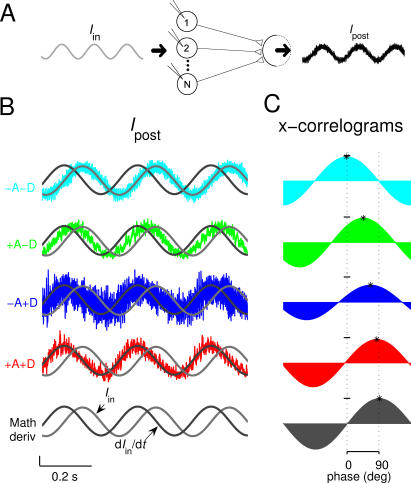
Phase Advances Induced by SFA and STD in the Network Model(A) Scheme of the spiking neuron network employed (N = 300).(B) Postsynaptic current I
post in response to sinusoidal input current I
in for the networks: no SFA and no STD (−A−D, cyan), SFA only (+A−D, green), STD only (−A+D, blue), and SFA plus STD (+A+D, red). Last panel: mathematical derivative dI
in/dt. All panels show I
in (gray) and dI
in/dt (black). Signals are plotted rescaled by their s.d. (vertical scale bar = 1 s.d.).(C) Cross-correlation functions between s.d.-rescaled I
in and I
post showing the phase shift induced by the various mechanisms. The off-center location and the height of the central peak are measures of the phase advancement and the signal-to-noise ratio in I
post, respectively.